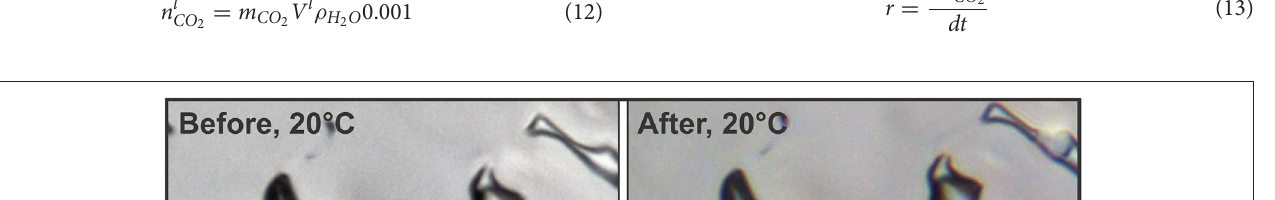
Frontiers in Climate |